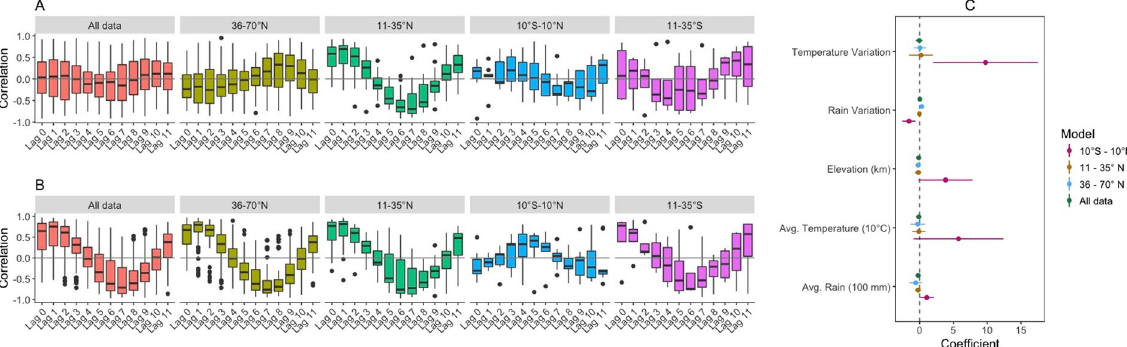
Figure 4. Association of environmental drivers with enteric or typhoid fever and seasonal intensity. The Pearson’s correlation coefficient between enteric or typhoid fever and ( A ) average monthly rainfall and ( B ) average monthly temperature (current and lagged (in months), up to 11 months) is summarized for all studies within a specified region. The values of the studies are represented in a boxplot, in which the whiskers represent the interquartile range (25 th –75 th percentile) times 1.5. ( C ) Coefficients from the meta-regression of the seasonal variation (peak/mean) against the average location-specific rainfall and temperature, the variation in average rainfall and temperature (peak/mean), and the study location’s elevation for all datasets with subnational data are plotted. The point estimates of the regression coefficients are represented by dots, while the 95% confidence interval is indicated by a horizontal